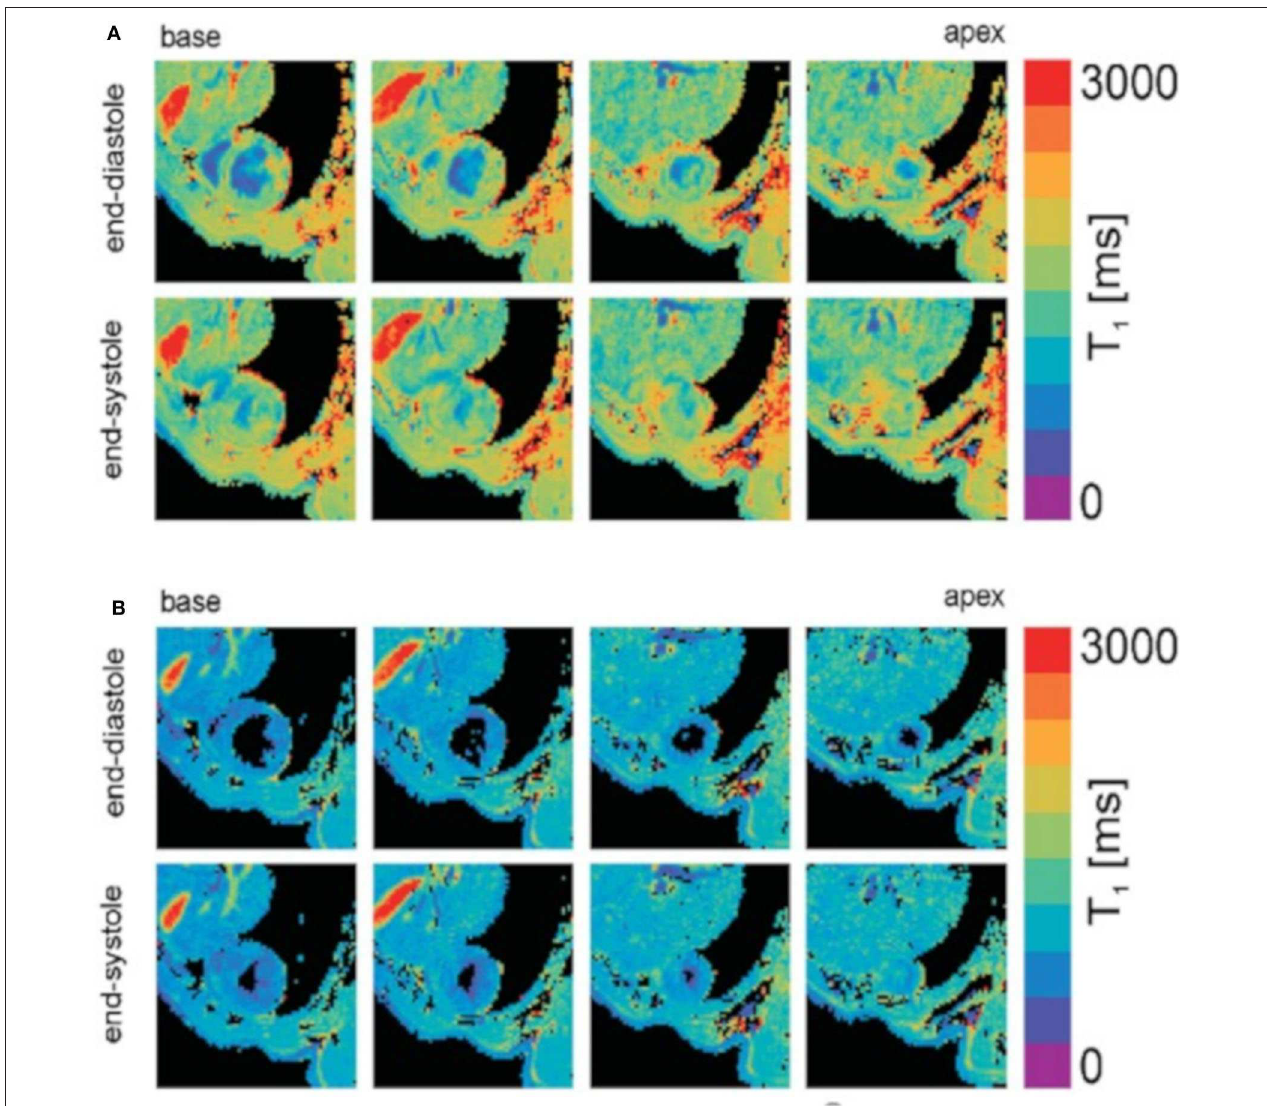
FIGURE 8 | T1 mapping of the mouse heart resulting from DESPOT1 analysis of both black-blood (A) and bright-blood (B) data. T1 maps are shown for four different slices covering the base to apex and for both the end-diastolic and end-systolic cardiac phases. Reproduced with permission from Coolen et al.